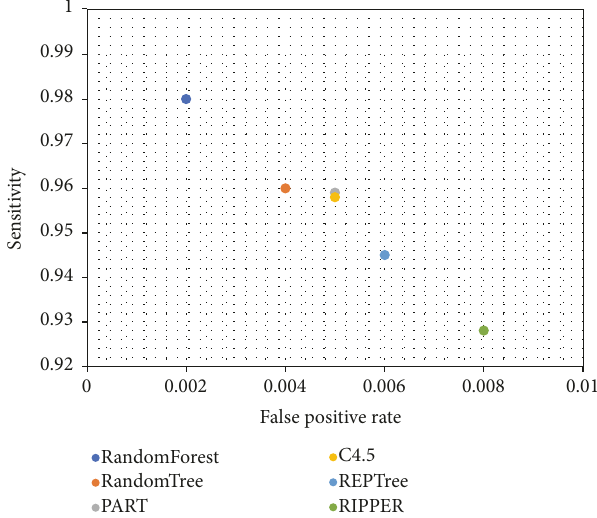
Figure 10: Rank positions (false positive rate, sensitivity) of classi- fiers.